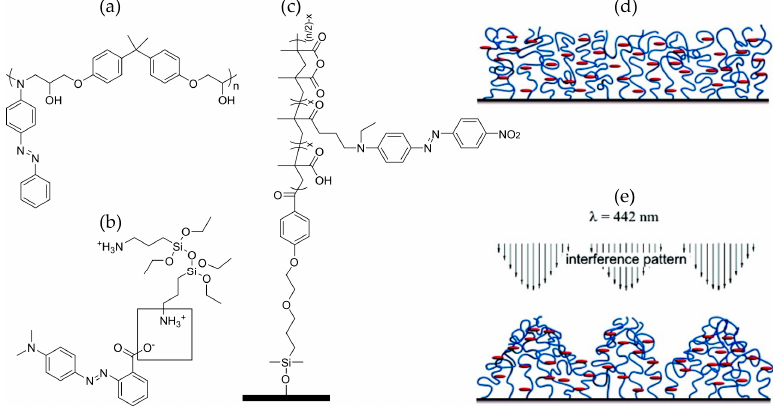
Figure 4. ( a ) Chemical structure of the polymer obtained by the oxirane ring opening reaction reported in reference [52,56]; ( b ) The chemical structure of complex formation obtained in the sol-gel material reported in reference [59]; ( c ) Chemical structure of the azo-functionalized poly(methacrylic acid) brush; ( d , e ) Schematic representation of the polymer brushes before ( d ) and after ( e ) interference pattern illumination. Note the polymer brushes create the maximum height in the low intensity region of the interference pattern. Reproduced from